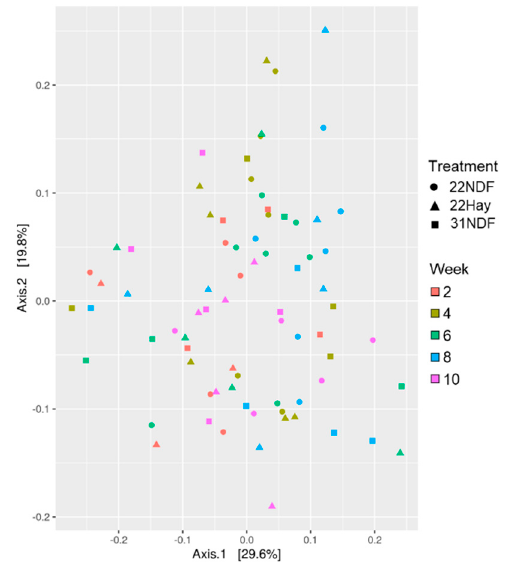
Figure 1. β -diversity of bacterial community in ruminal fluid samples in dairy calves fed different levels and sources of NDF. Multidimensional scaling (MDS) showing the weighted UniFrac distance metric; 22NDF—calves fed starter concentrate with 220 g NDF/kg; 22Hay—calves fed starter concentrate with 220 g NDF/kg and grass hay; 31NDF—calves fed starter concentrate containing 310 g NDF/kg.